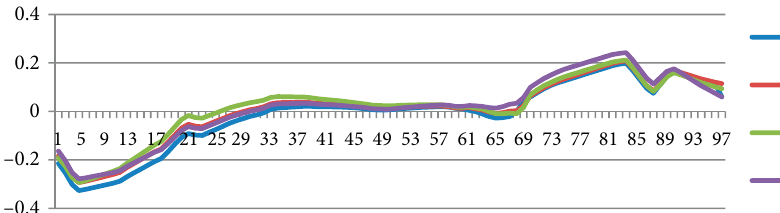
Fig. 11. Deviation of geoid heights N(m) from actual DEM a latitude 42.45